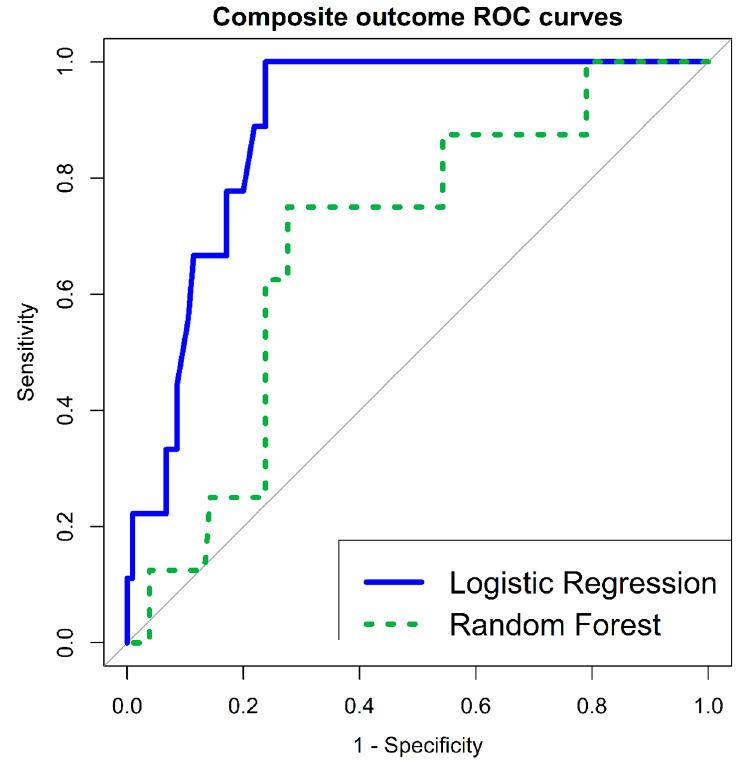
Figure 3. ROC curves—composite outcome (in-hospital mortality/VA/severe new HFrEF)—multivariate LR and RF classification models. HFrEF—Heart Failure reduced Ejection Fraction; LR—Logistic Regression; RF—Random Forest; ROC—Receiver Operating Characteristic; VA—Ventricular Arrhythmia.